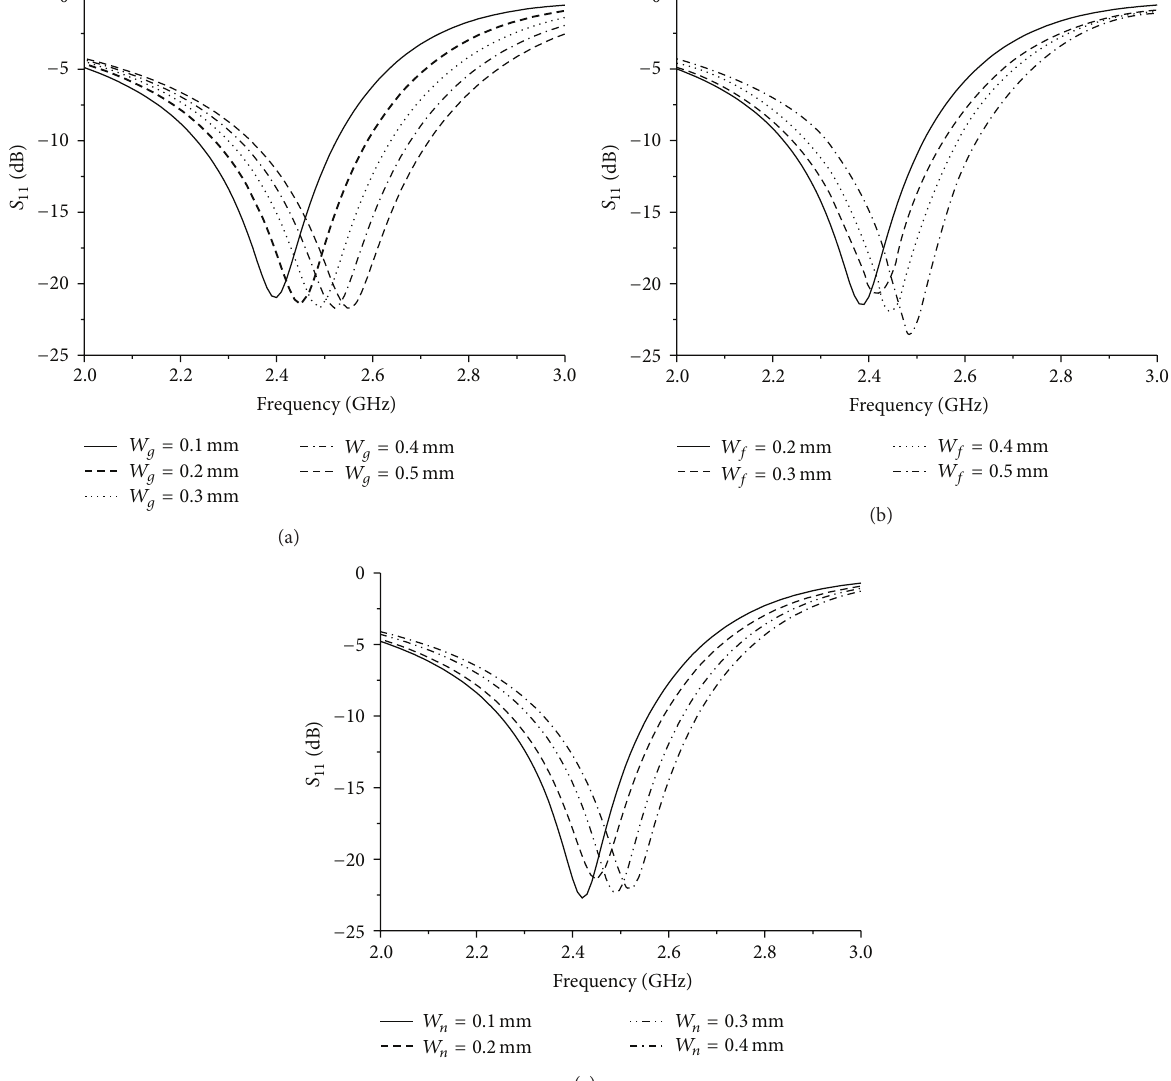
Figure 4 is opposite with the excited current on element number 2 in Figure